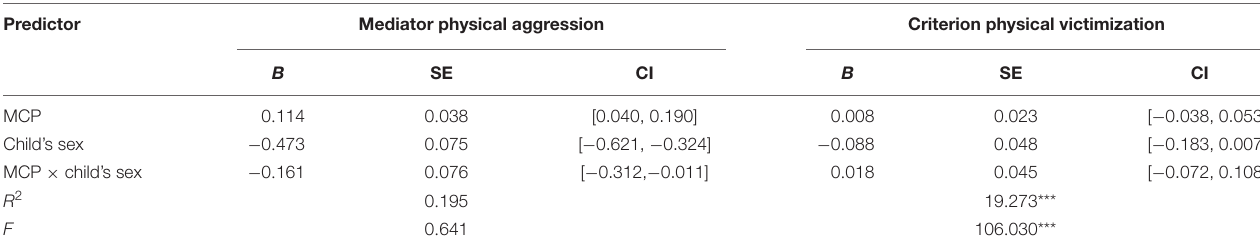
Predictor Mediator physical